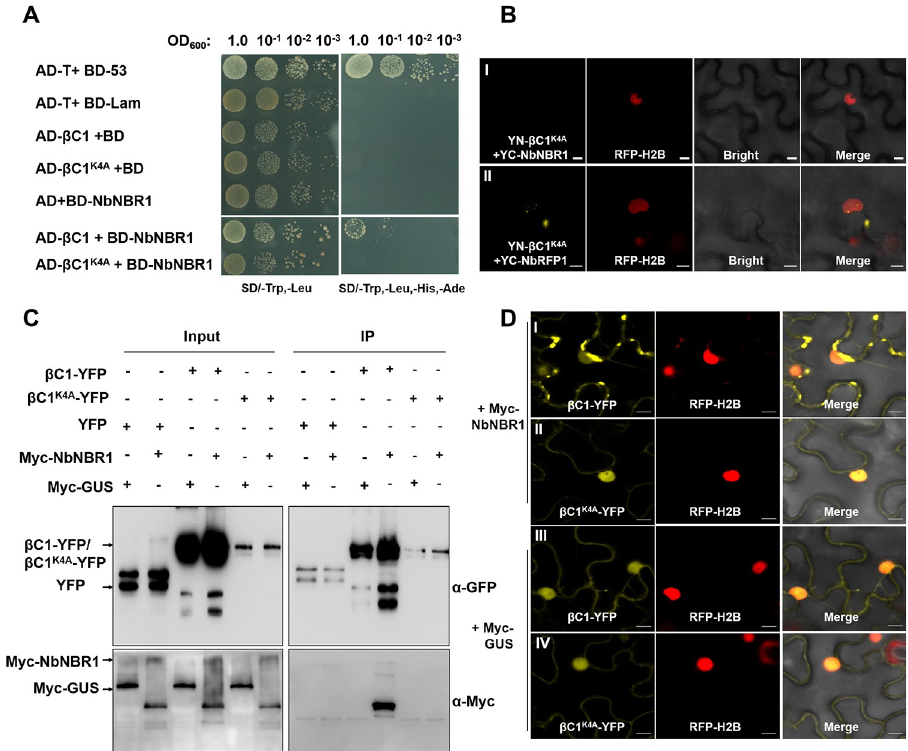
Fig 8. A single amino acid substitution in β C1 ( β C1 K4A ) abolishes the interaction between β C1 and NbNBR1. (A) Yeast cell cultures transformed with the indicated plasmids were 10-fold diluted and then grown on the SD/-Trp-Leu or SD/-Trp-Leu-His-Ade medium. Yeast cell culture co-transformed with AD- β C1+BD-NbNBR1 was used as the positive control. (B) YN- β C1 K4A +YC-NbNBR1, and YN- β C1 K4A +YC-NbRFP1 were co-expressed, respectively, in RFP-H2B transgenic N . benthamiana leaves followed by confocal microscopy at 48 hpi. Bar = 10 μ m. (C) Co-IP assay was performed to validate the interaction between Myc-NbNBR1 and β C1-YFP, and Myc-NbNBR1 and β C1 K4A -YFP. Input and IP represent the samples made before and after immunoprecipitation, respectively. Western blot assays were performed using anti-GFP and anti-Myc antibodies. (D) β C1-YFP and β C1 K4A -YFP were, respectively, co-expressed with Myc-NbNBR1 or Myc-GUS in RFP-H2B transgenic N . benthamiana leaves followed by confocal microscopy at 48 hpi. Bar = 10 μ m. The protein expression of the integrity of fused proteins was confirmed in S7C Fig.